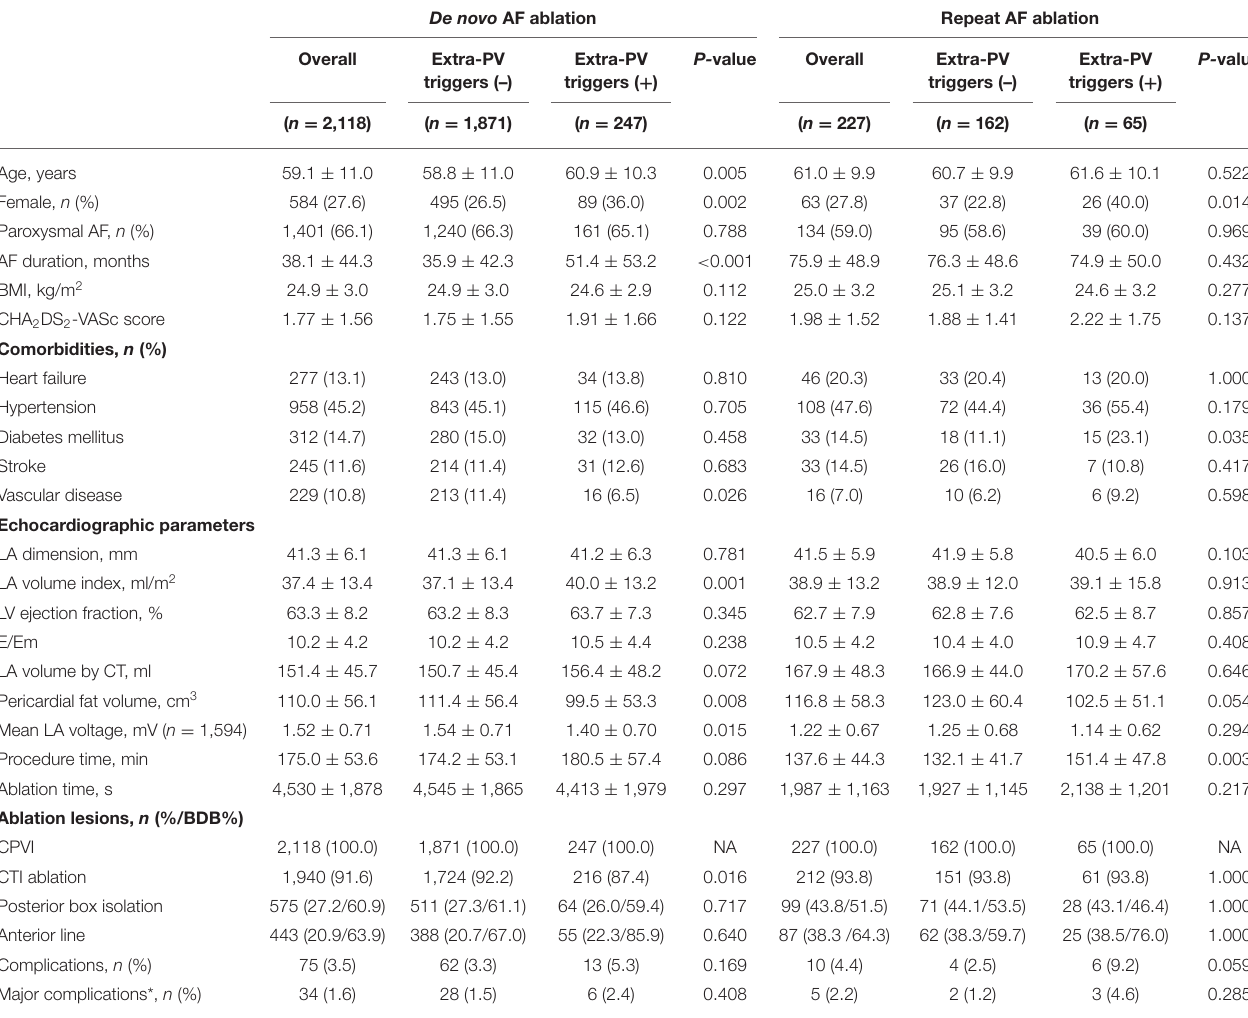
TABLE 1 | Baseline clinical and procedural characteristics according to the existence of extra-PV triggers.